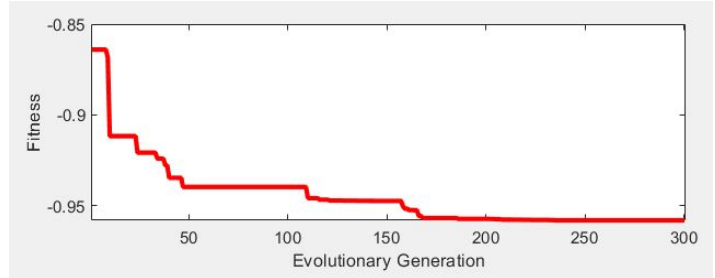
Figure 12. Optimization process by GA.